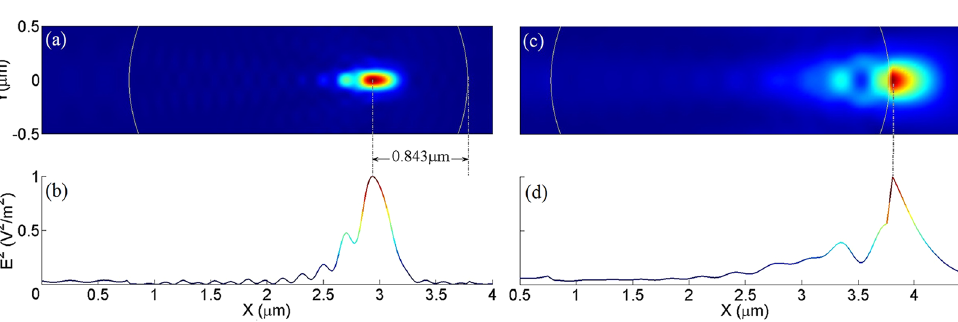
Figure 2. The electric intensity distribution ( a , b ) before and ( c , d ) after compensation of SAs. ( b , d ) are the electric intensities along the center line (i.e., y = 0) in ( a , c ), respectively. The parameters for calculation are: n 1 = 1.34, n 2 = 2.67 ( a , b ), n 2 = 1.57 ( c , d ), r = 1.5 μ m and λ 0 = 0.69 μ m. White curves indicate the front and rear edge of microsphere. Note that the electric intensity is normalized to